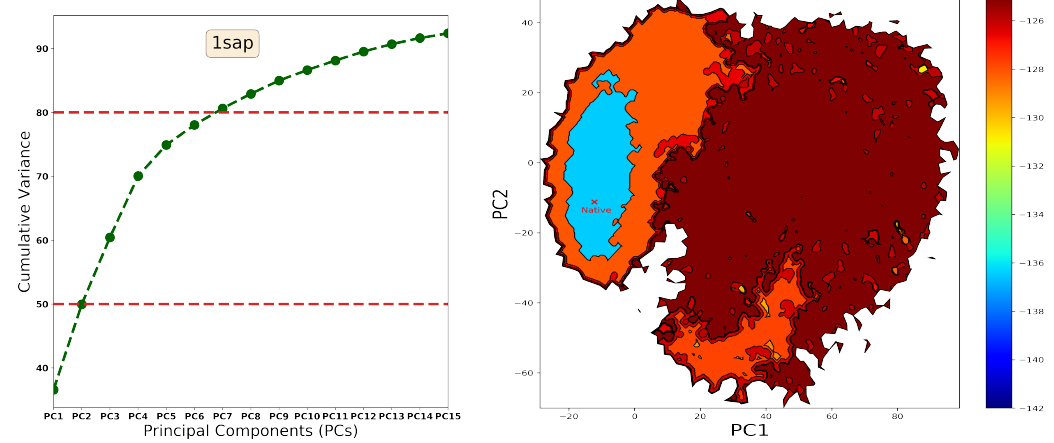
Figure 4. Results for medium targets